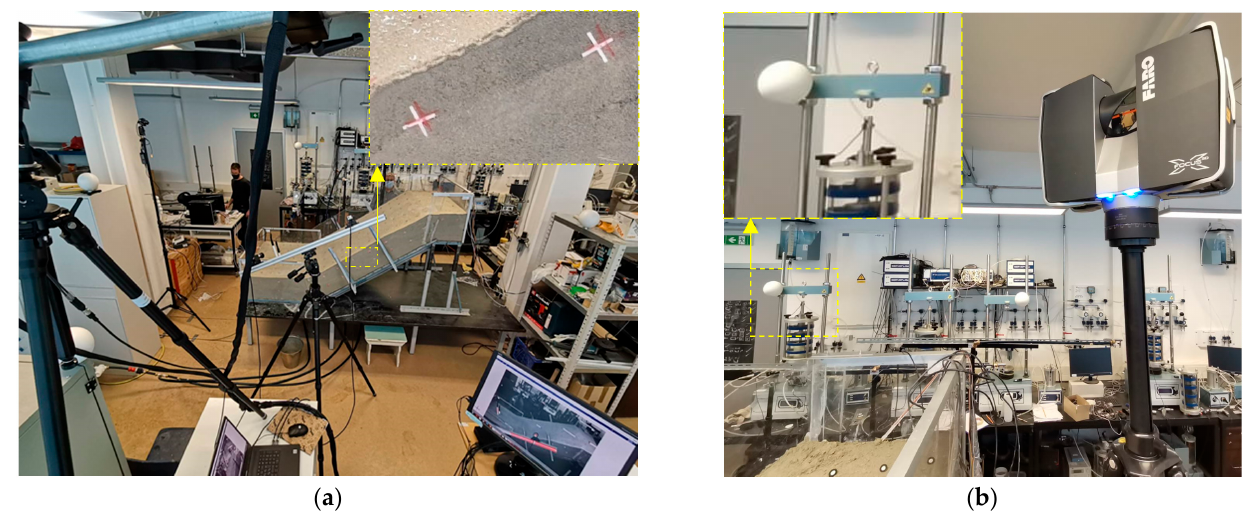
Figure 3. Geodetic monitoring equipment: ( a ) A view of the model from the ARAMIS measuring system (GOM mbH, Braunschweig, Germany) and a detail from the (front) 12-megapixel camera mon- itoring displacements through the plexiglass wall; ( b ) The FARO Focus 3D X 130 (FARO Technologies Inc, Lake Mary, USA) terrestrial laser scanner and a detail of the reference sphere